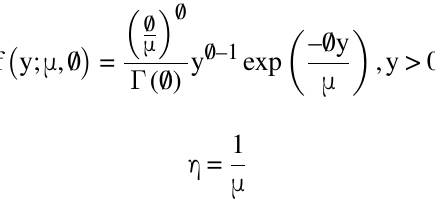
Total f is absolute frequency in the forest inventory, n is number of trees sampled for Eucalyptus saligna ( Esa ) and Eucalyptus grandis × Eucalyptus urophylla ( Eug